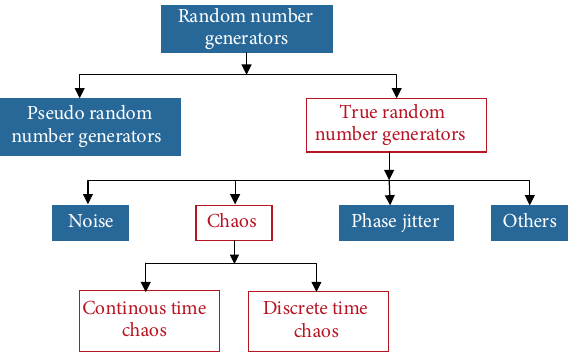
Figure 1: The architecture of random numbers